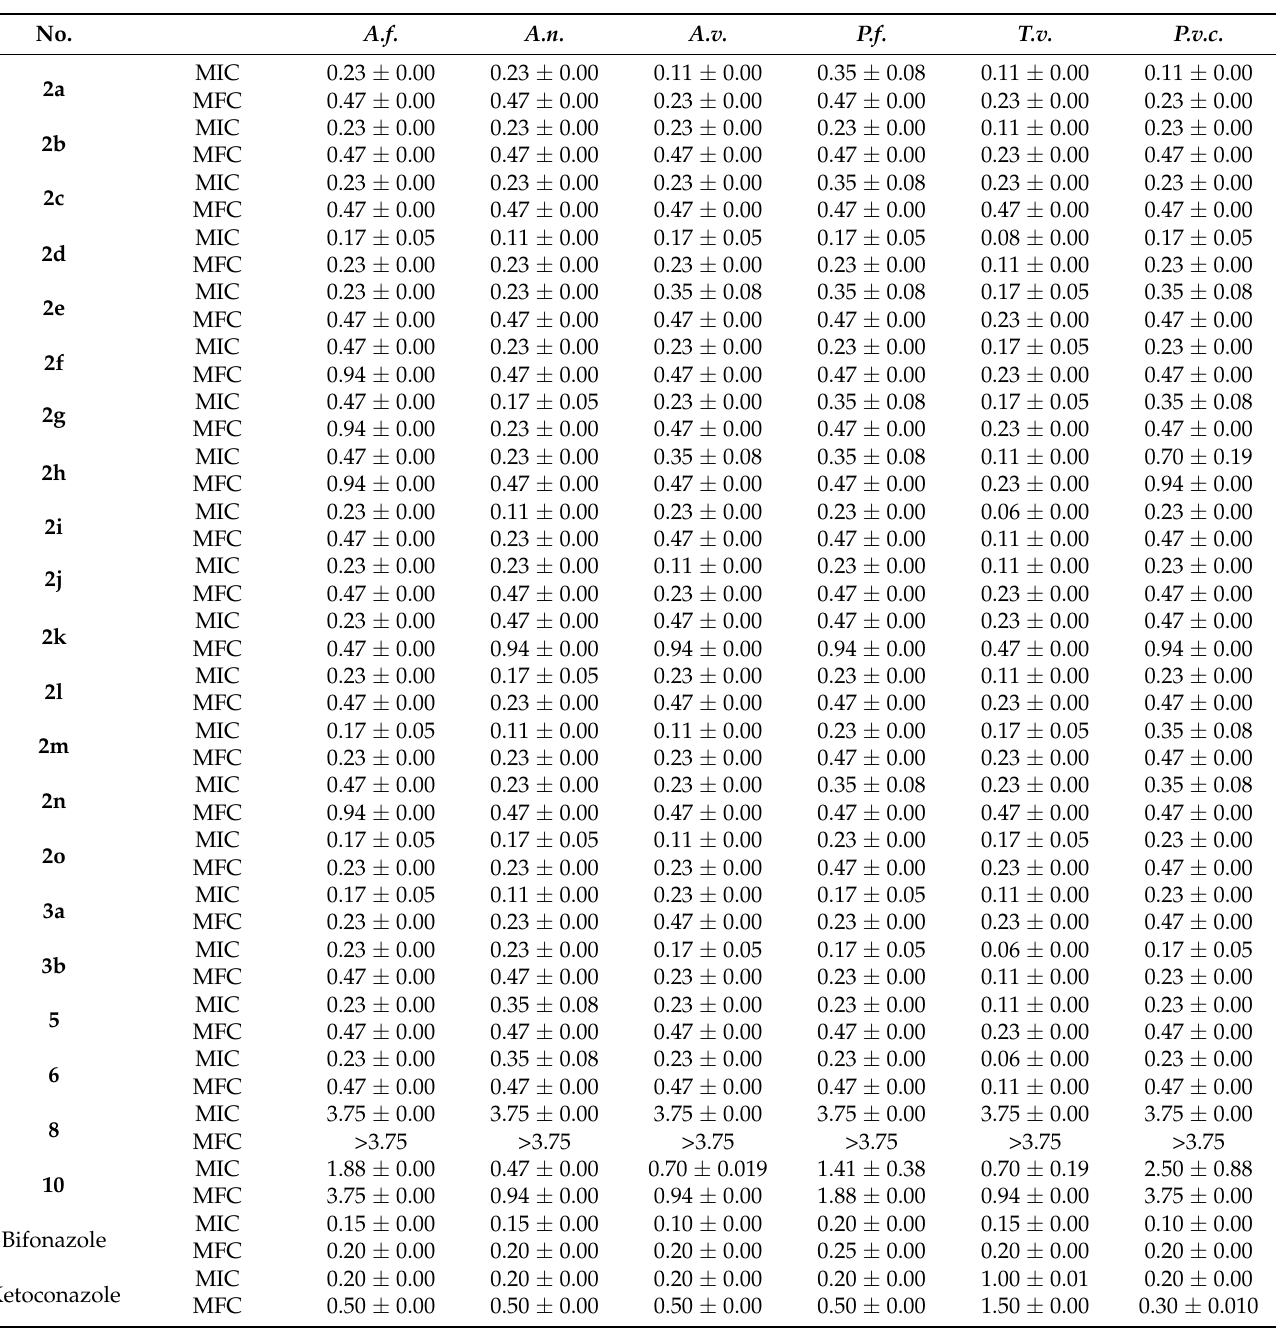
Table 2. Antifungal activity of heteroaryl derivatives of benzothiazole